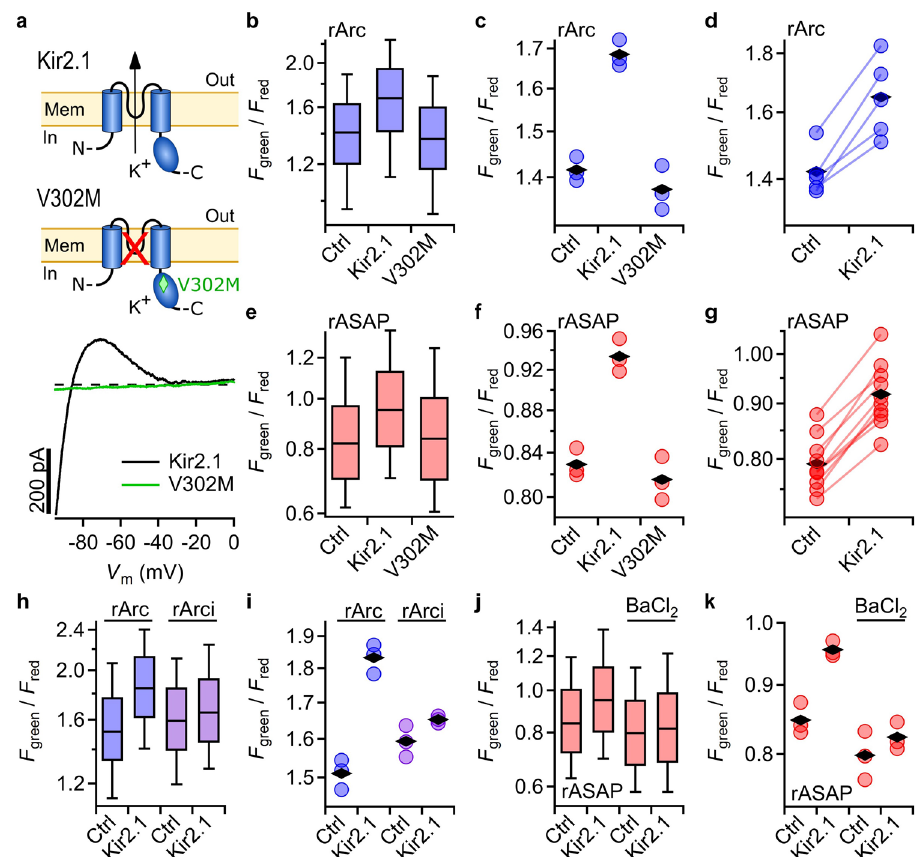
Fig. 3 Measurement of Kir2.1-induced HEK293T cell hyperpolarization. a Schematics of one of four subunits forming a functional inward recti fi er K + channel Kir2.1 or the nonconducting variant V302M, which causes the Andersen-Tawil syndrome; bottom, representative current traces as function voltage for mouse Kir2.1 (black) or variant V302M (green), expressed in HEK293T and recorded in whole-cell patch-clamp con fi guration. Dashed line indicates zero current level. b Boxplots of F green / F red from images of HEK293T cells expressing rArc alone (Ctrl) or coexpressing Kir2.1 or Kir2.1-V302M. c Median ratio values of three independent samples measured on the same day; black rhombi indicate means of the median values. d F green / F red from samples with rArc (Ctrl) or rArc-Kir2.1 from fi ve different measurement days. Each data point is the mean of at least three individual median measurements (as in ( b , c )). Data points connected by lines were acquired on the same day. e – g As in ( b – d ) but with cells coexpressing rASAP; from 10 days in ( g ). h Boxplots of F F green / red from cells expressing rArc or rArci, a rArc variant with reduced voltage sensitivity (Supplementary Fig. 6), with and without Kir2.1 and ( i ) median values of three separate samples. j Boxplots of F green / F red of cells expressing rASAP alone or coexpressing mKir2.1 with or without the mKir2.1 blocker BaCl 2 (1 mM) and k , median ratio values of three independent